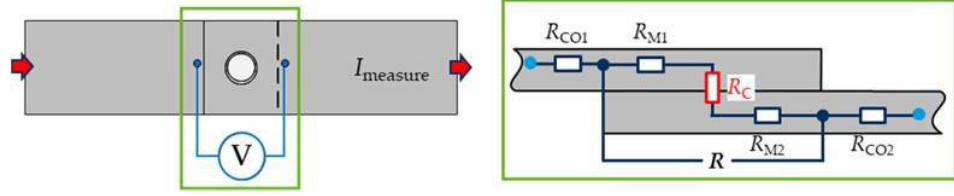
Figure 3. Measuring principle for determining the resistance of clinched joints [3].